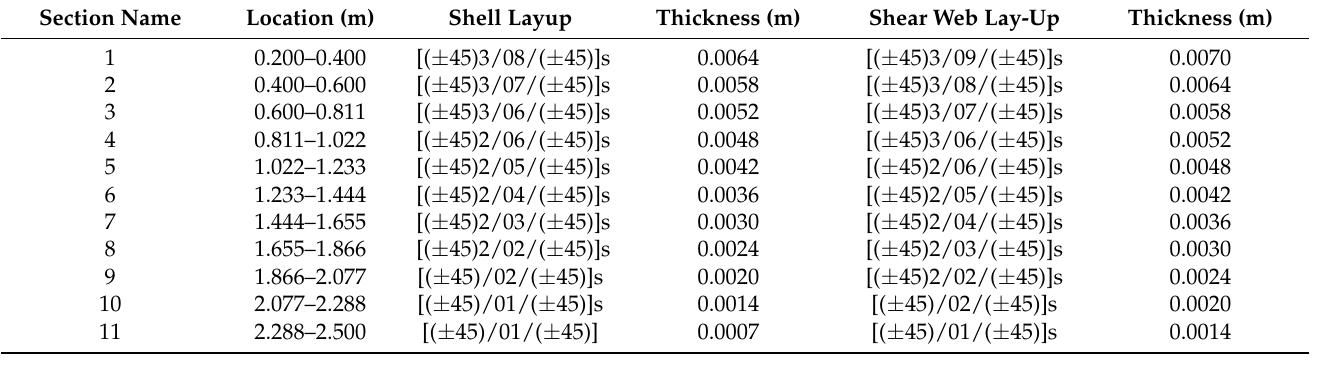
Table 3. The lay-up sequence of 2.5 m small wind turbine.